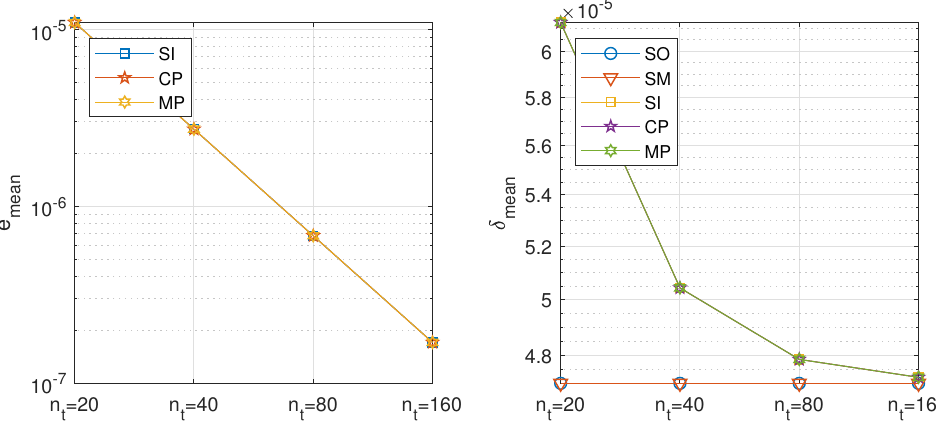
Figure 7. Diffusion problem, balanced decomposition. Precision of the proposed methods: sequential iterative SI, classical parallel CP, and modern parallel MP, compared with the classical ones: sequential operator SO and Strang–Marchuk SM, with fourth order approximations for the spatial derivatives for different number of time